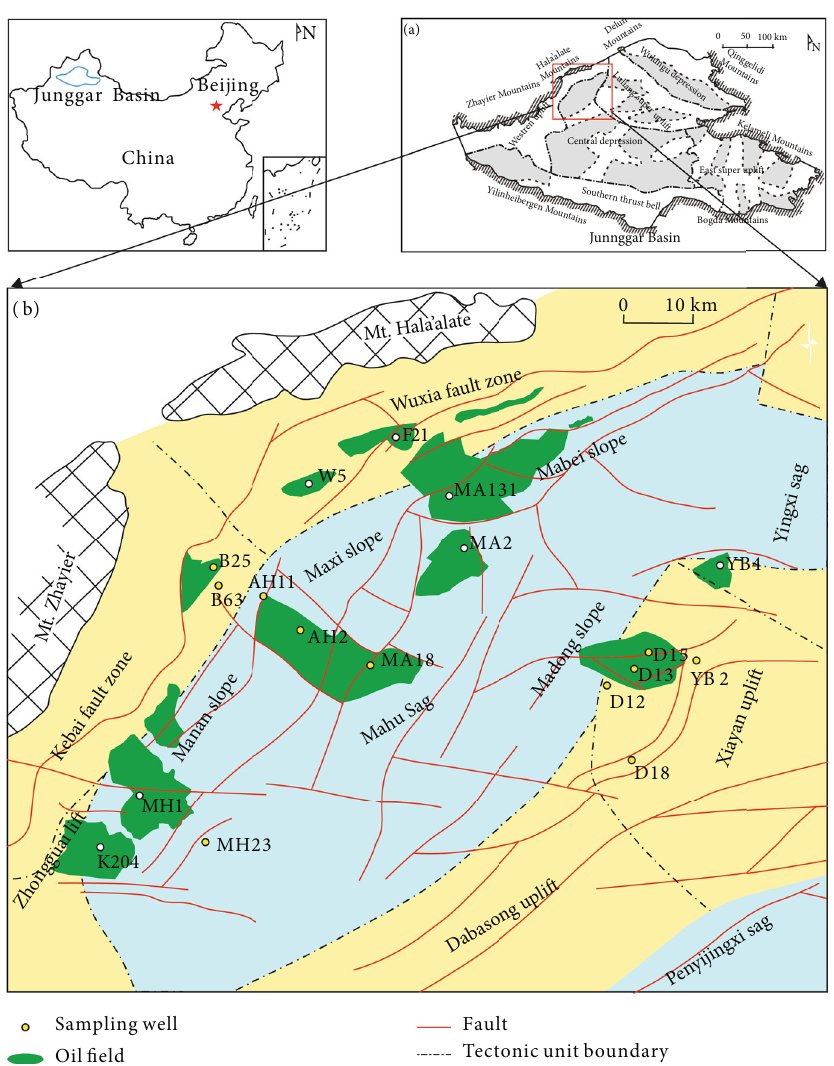
Figure 1: (a) Map showing the location and major tectonic units of the Junggar Basin. (b) Map showing the distribution of major oil fi elds and sampled wells in the Mahu Sag (modi fi ed after PetroChina Xinjiang Oil fi eld Company,